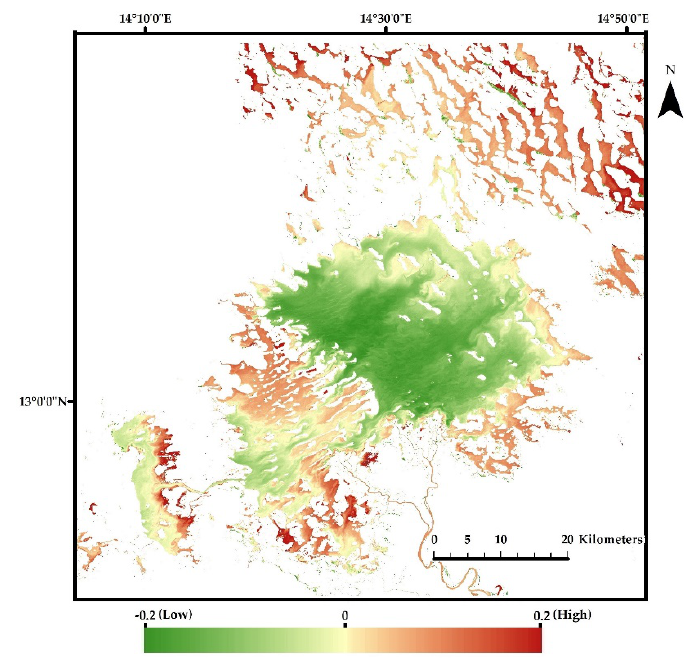
Figure 8. Results of 3BDA Chl a concentration spatial pattern in the southern pool of Lake Chad from Sentinel-2 at 20-m spatial resolution. Increasing concentrations of Chl a are depicted by brighter pixels.